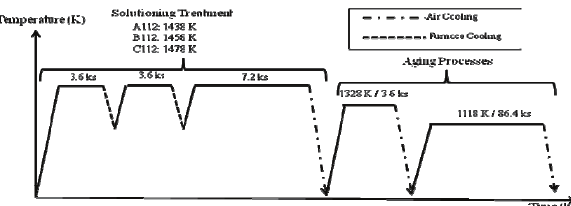
Figure 9. Simulated reheat treatment programs: A112, B112 and